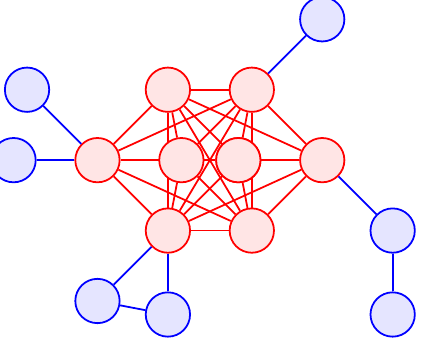
Figure 4: A network with a highly-connected subnetwork, indicated in red.